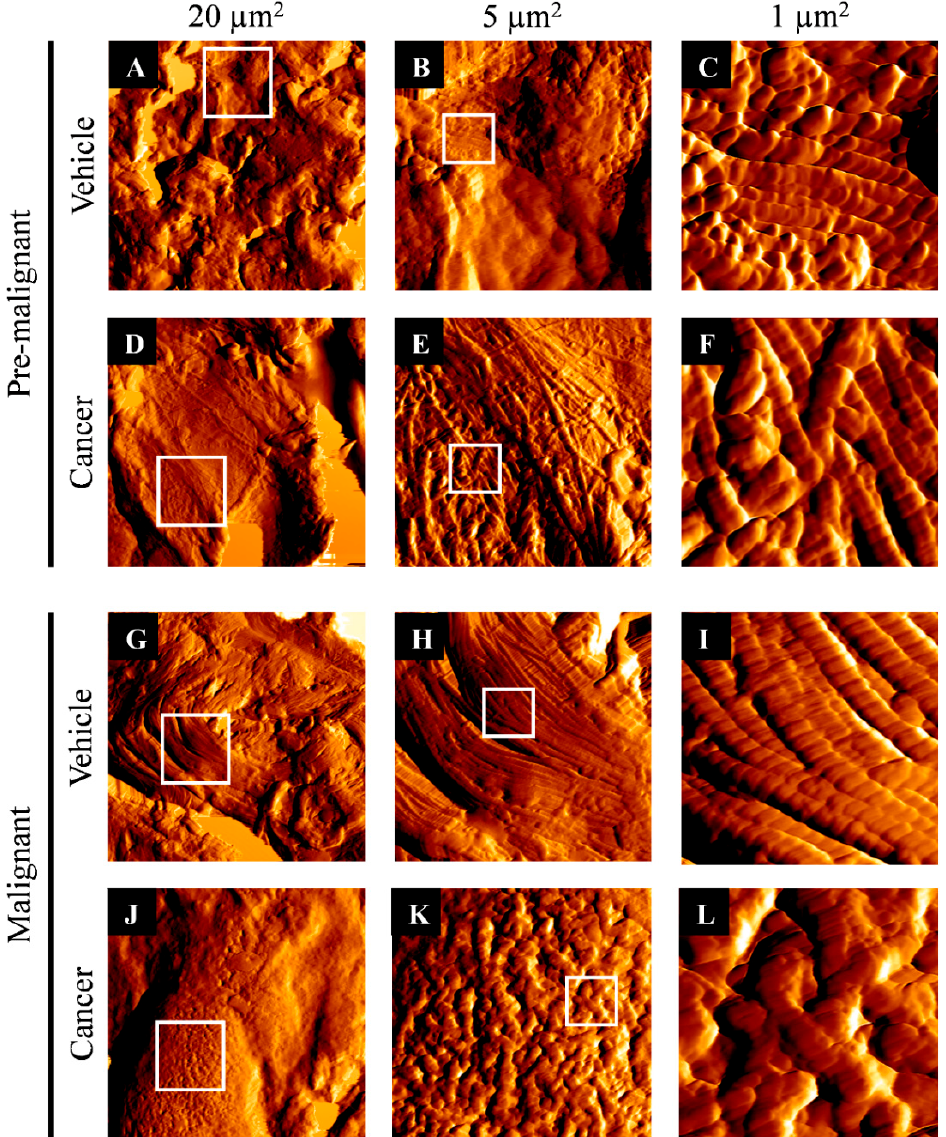
Figure 2. Collagen fibrils at the bronchial area of the Vehicle and Cancer groups from both stages of carcinogenesis, in an area of 20 µ m 2 , 5 µ m 2 , and 1 µ m 2 . ( A – C ) show the images of collagen fibrils from the Pre-malignant Vehicle group. ( D – F ) show the images of collagen fibrils from the Pre-malignant Cancer group. ( G – I ) show the images of the Malignant Vehicle group. ( J – L ) show the images of collagen fibrils from the Malignant Cancer group. The white border-box is the area selected for the subsequent magnified image scans using atomic force